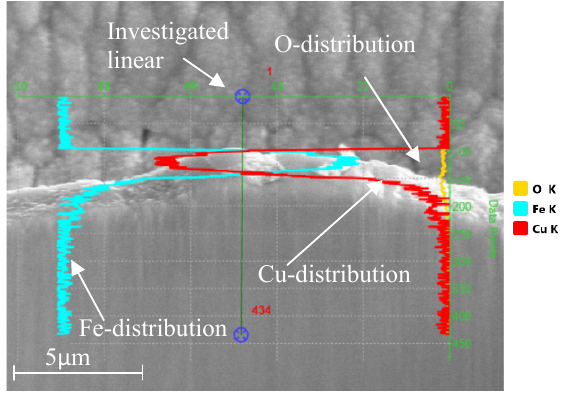
Figure 9. SEM Linear element analysis of the ion-machined section on the tested surface with the 0.5 wt% oil sample